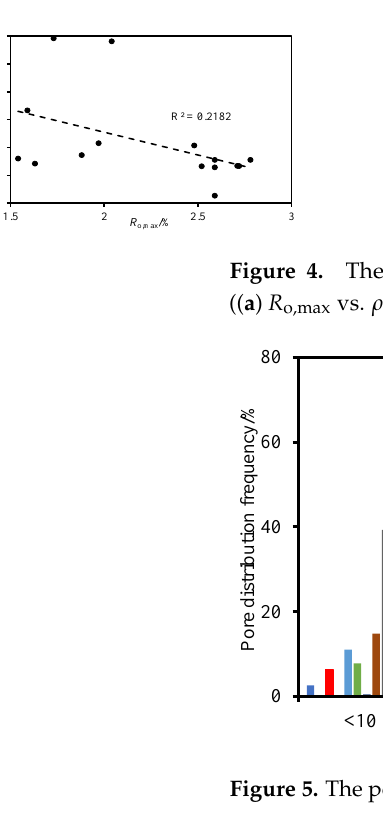
fitting part with a positive slope when q < 0 (the near-horizontal part), indicating that the pores of middle- and high-rank coal have multifractal behavior in different pore diameter segments [30]. Second, with the increase in q , the fitting curve gradually becomes dense, which indicates that the pores of the coal sample are mainly distributed in a small interval of the characterized pore size range.